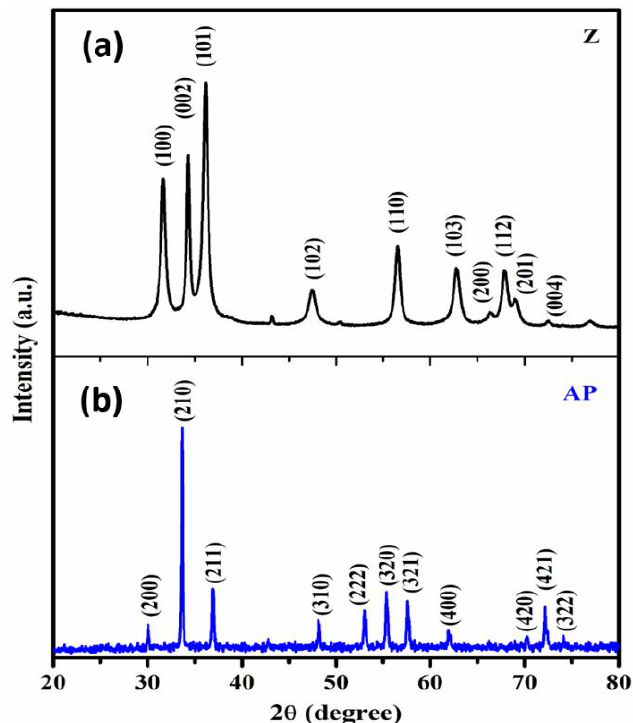
Figure 1. ( a , b ) The XRD patterns for pure ZnO and Ag 3 PO 4 samples,